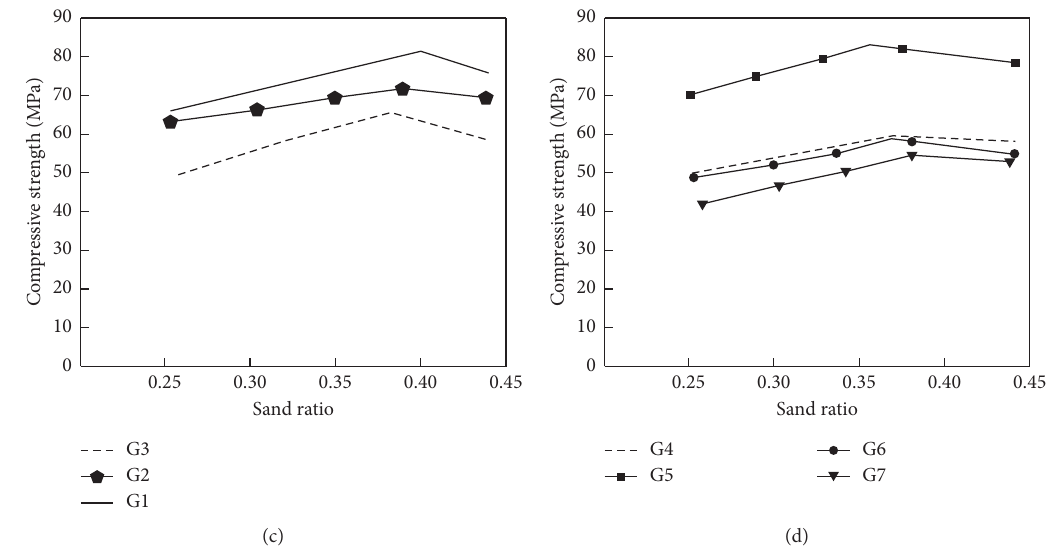
Figure 8: The variation of compressive strength of coal gangue-based polymer concrete with sand ratio. (a) Seven-day compressive strength (G1–G3). (b) Seven-day compressive strength (G4–G7). (c) 28-day compressive strength (G1–G3). (d) 28-day compressive strength